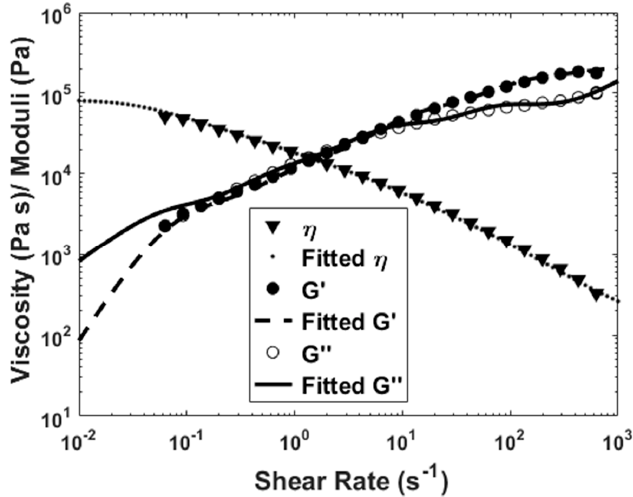
Figure 3. Curve fitting the experimental rheology data using the Phan–Thien–Tanner model.